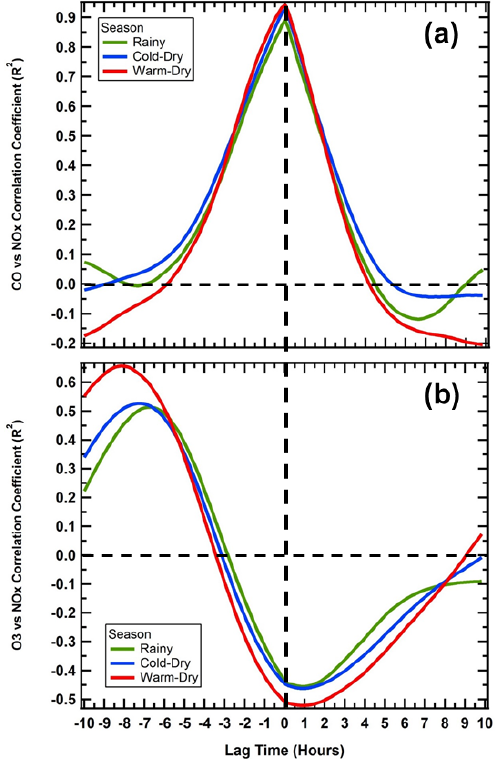
Figure 11. These plots illustrate the correlations between (a) CO and NO x , (b) , O 3 and NO x , as a function of the lag time and differ- entiated by season. The vertical dashed line shows the correlation of the parameters at no lag time. The horizontal dashed line demarks the crossover from positive to negative correlation. The lag time was varied by 10min